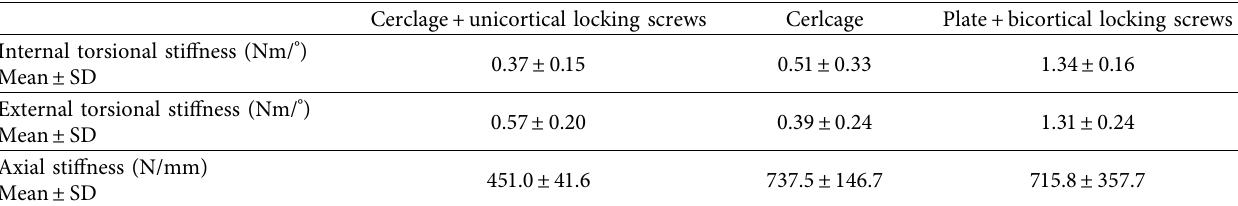
Figure 4: (a) Box plot showing the internal rotational stiffness of the three samples. The fixation with 2x plates provided the highest internal rotational stiffness, followed by both that with 3x cerclage wires and that with 1x cerclage and 2x screws which in turn displayed a somewhat similar stiffness, where the difference between groups 1 and 3 as well as those between 2 and 3 were statistically significant. (b) Box plot showing the external rotational stiffness of the three samples. The fixation with 2x plates provided the highest external rotational stiffness, followed by that with 3x cerclage wires and then by that with 1x cerclage and 2x screws, where the difference between groups 1 and 2, groups 2 and 3, and groups 1 and 3 were statistically significant. (c) Box plot showing the axial stiffness of the three samples. The fixation with 3x cerclage wires provided the highest axial stiffness, followed by that with 2x plates and then by that with 1x cerclage and 2x screws, where the difference between groups 1 and 2 were statistically Table 1: An overview table of the results in terms of mean value and standard deviation for each of the three groups.